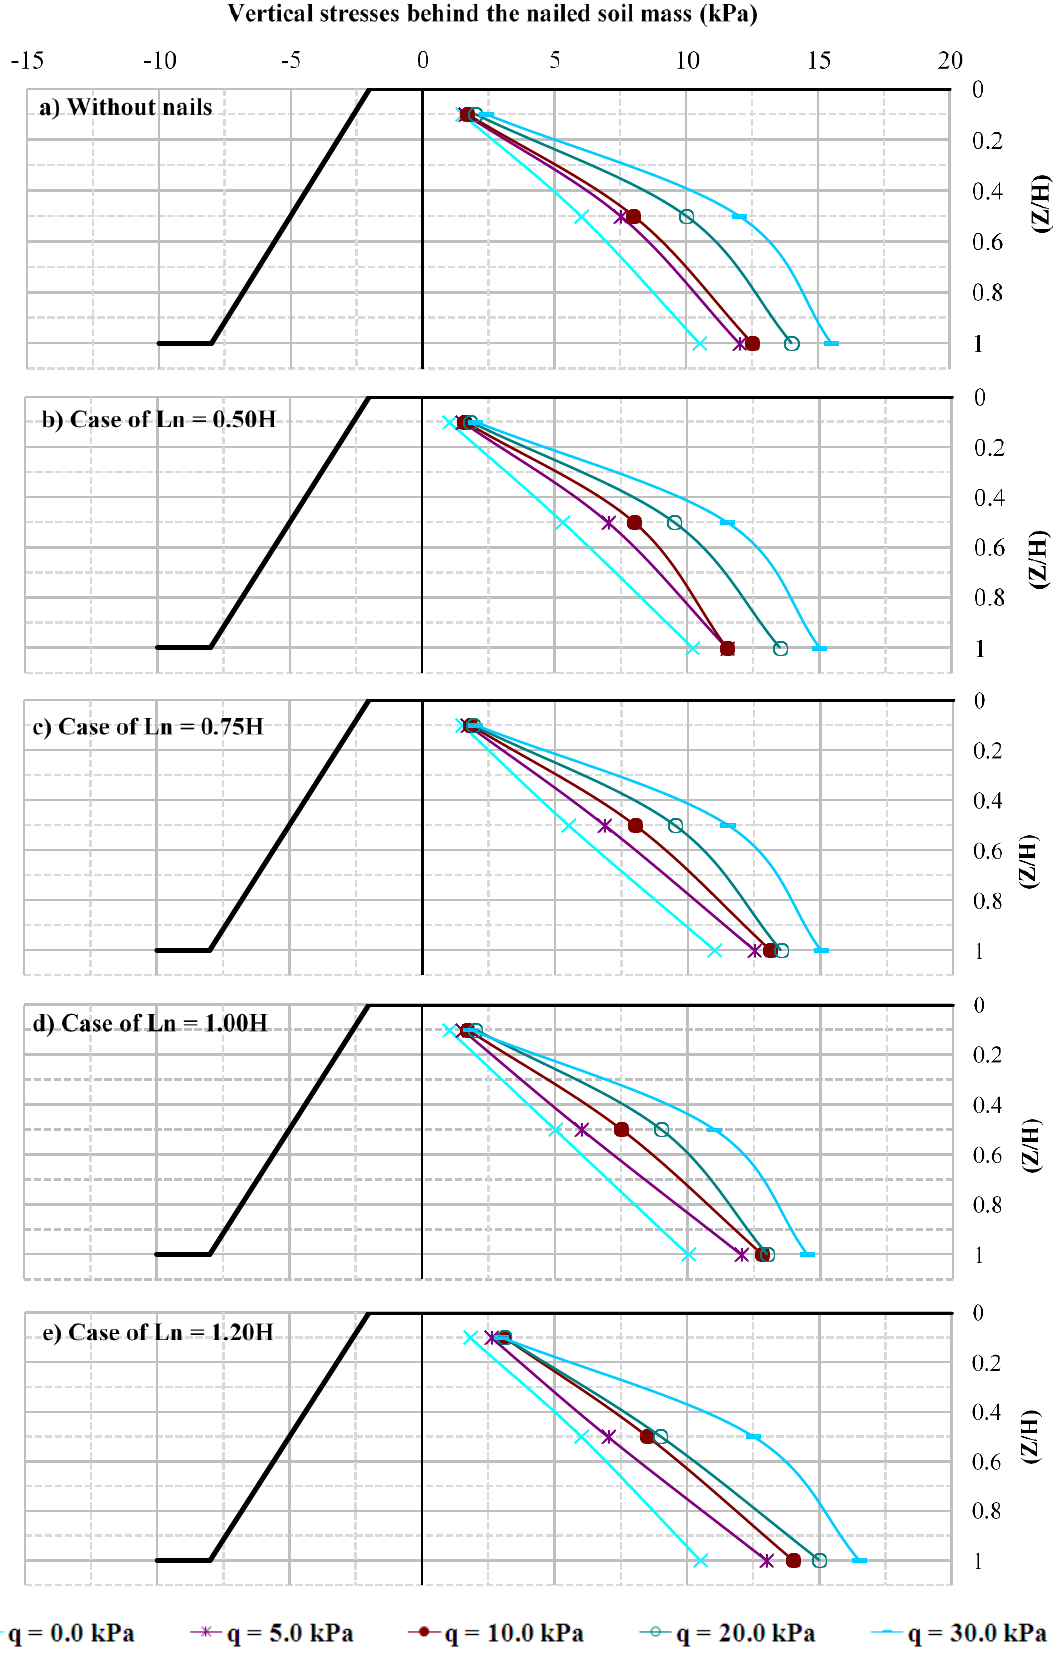
Figure 14. Distribution of vertical stresses behind the soil mass at different nail lengths.